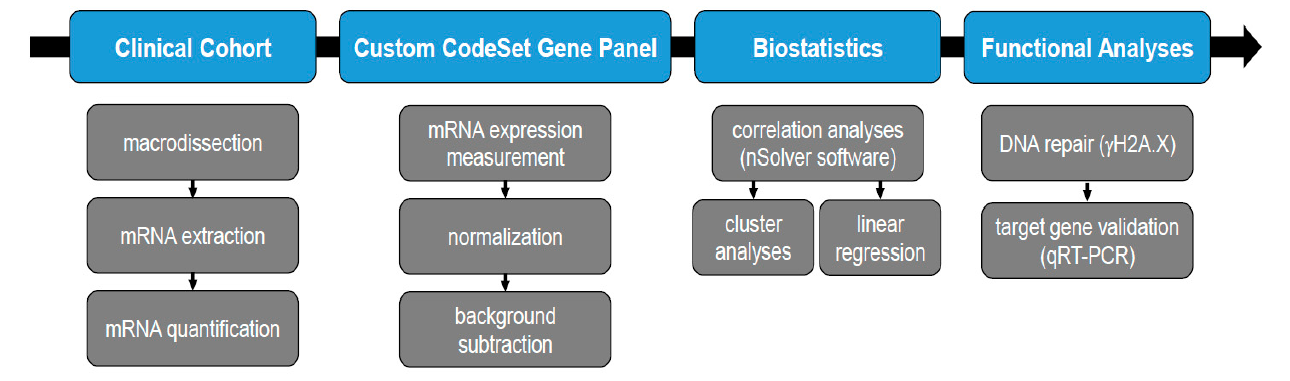
Figure 1. Flow chart of the main steps in this study: material processing, data acquisition, biostatistical analyses and experimental validation.